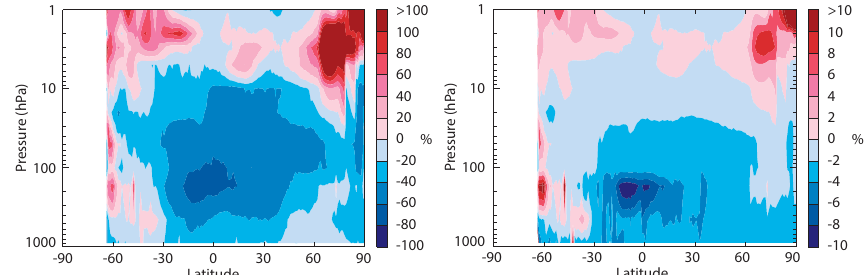
Figure 5. Left panel: vertical cross section of the difference between the estimated and the provided uncertainty relative to the provided uncertainty for GOME-2 NPO 3 over the period July–October 2008. Negative (positive) values in blue (red) colours mean that the provided uncertainty is larger (smaller) than that estimated with the Desroziers et al. (2005) method. Data are in percent. Right panel: as in the left panel but with relative difference computed with respect to the observation instead of its provided uncertainty. Data are in